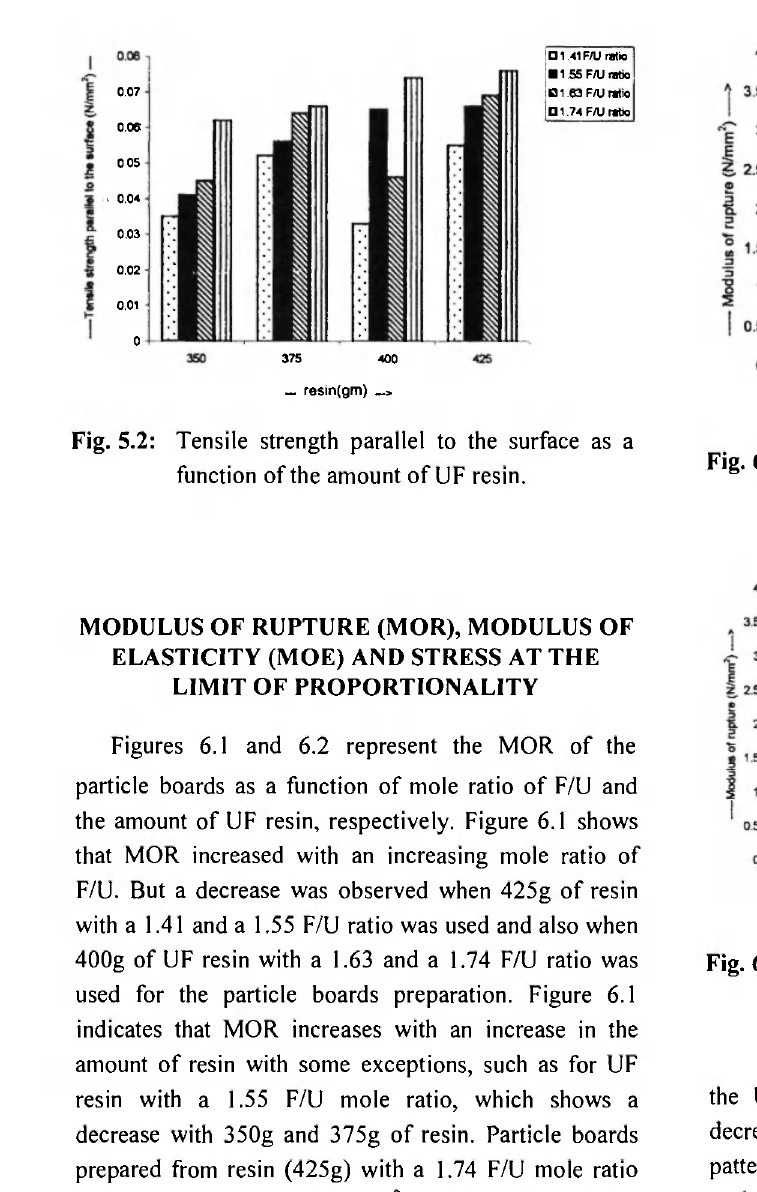
1: Modulus of rupture as a function of the mole ratio of HCHO:Urea.